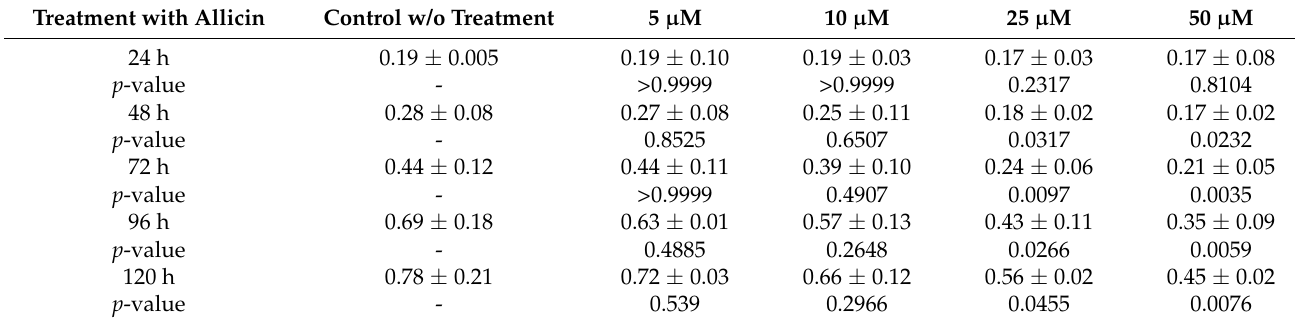
Table 7. LAG-3 gene expression in 2 µ L/mL GCF-treated CD3+ T cells treated with different concentrations of allicin (Mean ±